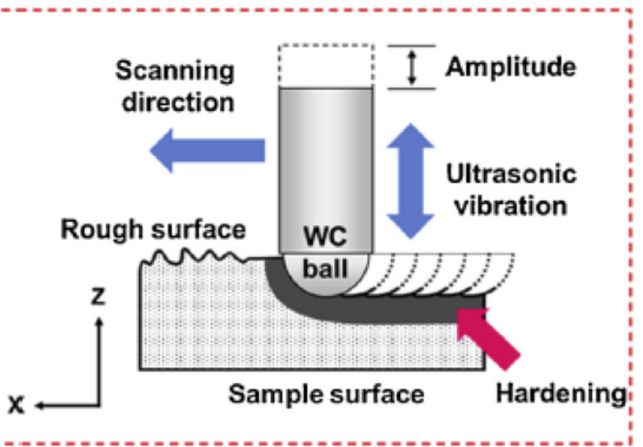
Figure 3. Schematic of generation of a UNSM-modified surface on the material’s surface. Reprinted with permission from ref. [45]. Copyright 2020, Elsevier.